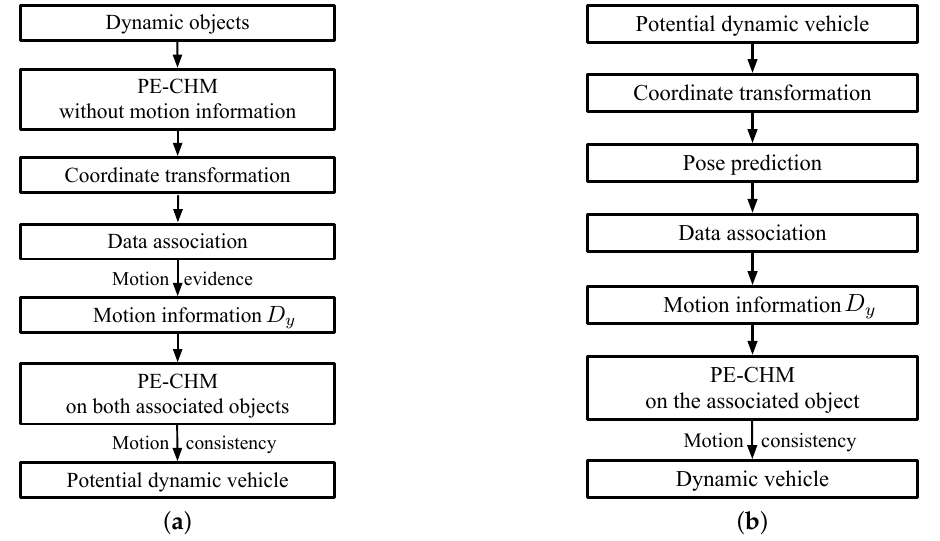
Figure 7. Flowchart of dynamic vehicle detection. ( a ) Potential dynamic vehicle detection. ( b ) Dynamic vehicle